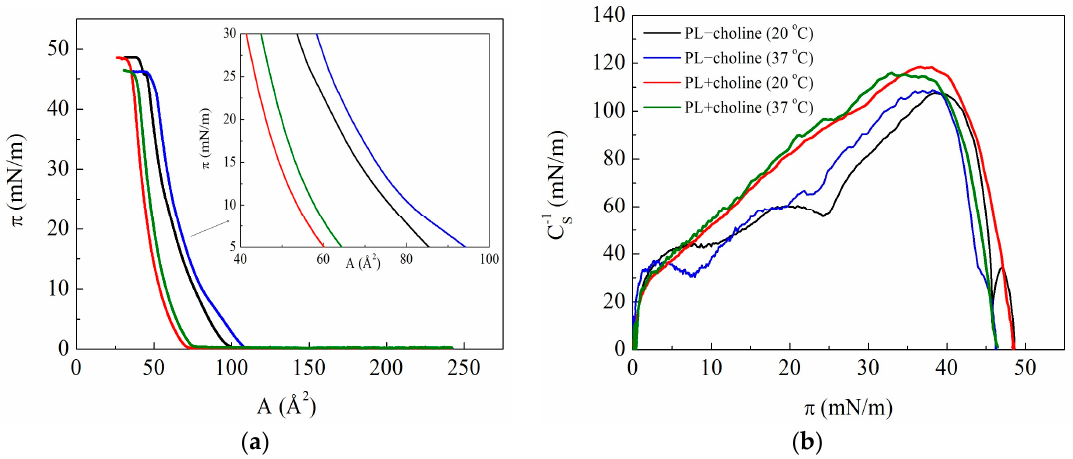
Figure 2. Surface pressure-area per molecule ( π − A ) isotherms registered at 20 °C and 37 °C ( a ) and determined the compression modulus-surface pressure ( C (cid:2903)(cid:2879)(cid:2869) − π ) dependencies based on them ( b ) for the monolayers of phospholipids (PL) extracted from L. gormanii bacteria supplemented (PL+choline) or not (PL − choline) with choline.